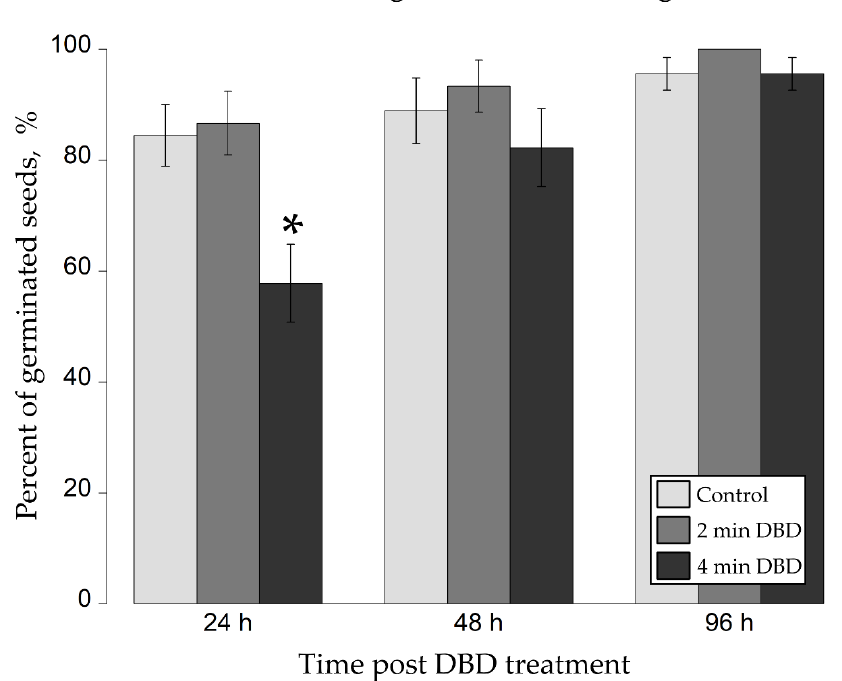
Figure 3. Effect of the NTAPP treatment on the germination rate of mung bean seeds. The seeds were exposed to DBD, being the NTAPP source, for 0, 2, or 4 min. The number of the germinated seeds was calculated after 24, 48, and 96 h of incubation. Bars correspond to the means ± standard errors. Asterisk shows a statistically significant difference in comparison to the untreated control sample (Student’s t -test at p <